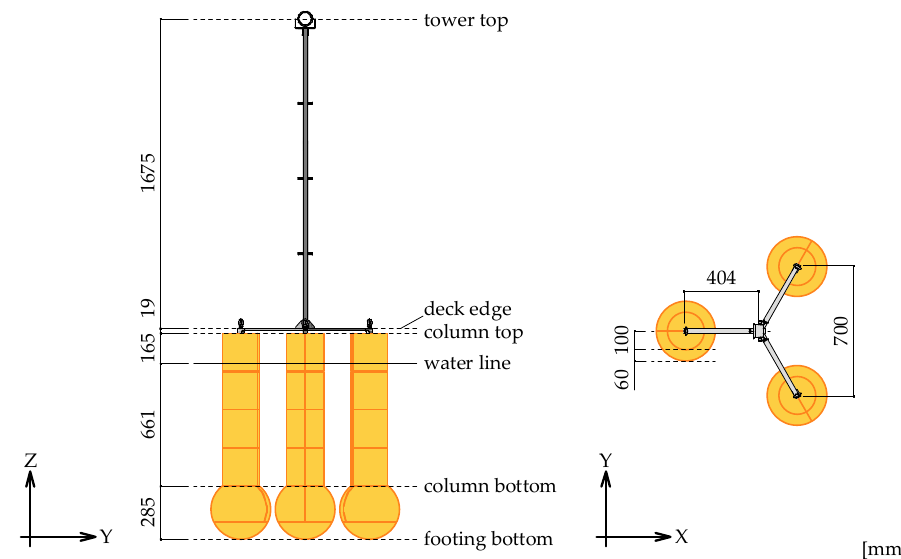
Figure 1. Main dimensions of the reduced scale model, basic case Sphere Model. Core stainless (SUS304) beams were used to represent the model elastic similarity (provide the structural rigidity), and the urethane pieces were wrapped around the core beams to define the geometry similarity. The urethane parts were segmented to avoid additional stiffness. A picture of the reduced scale model is shown in Figure